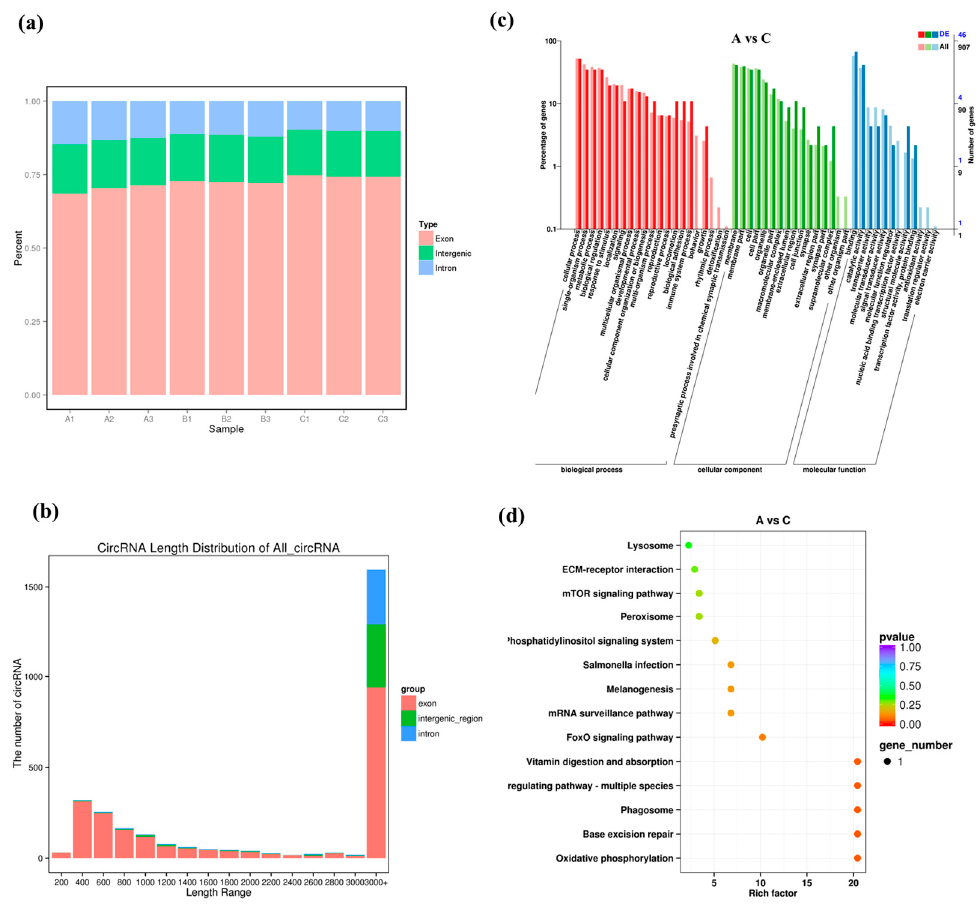
Figure 3. Identification and analysis of DECs under salinity stress. ( a , b ) Type distribution and Sequence length of all identified circRNAs. ( c ) GO enrichment analysis of DECs in groups A vs. C. ( d ) KEGG enrichment analysis of DECs in groups A vs. C.